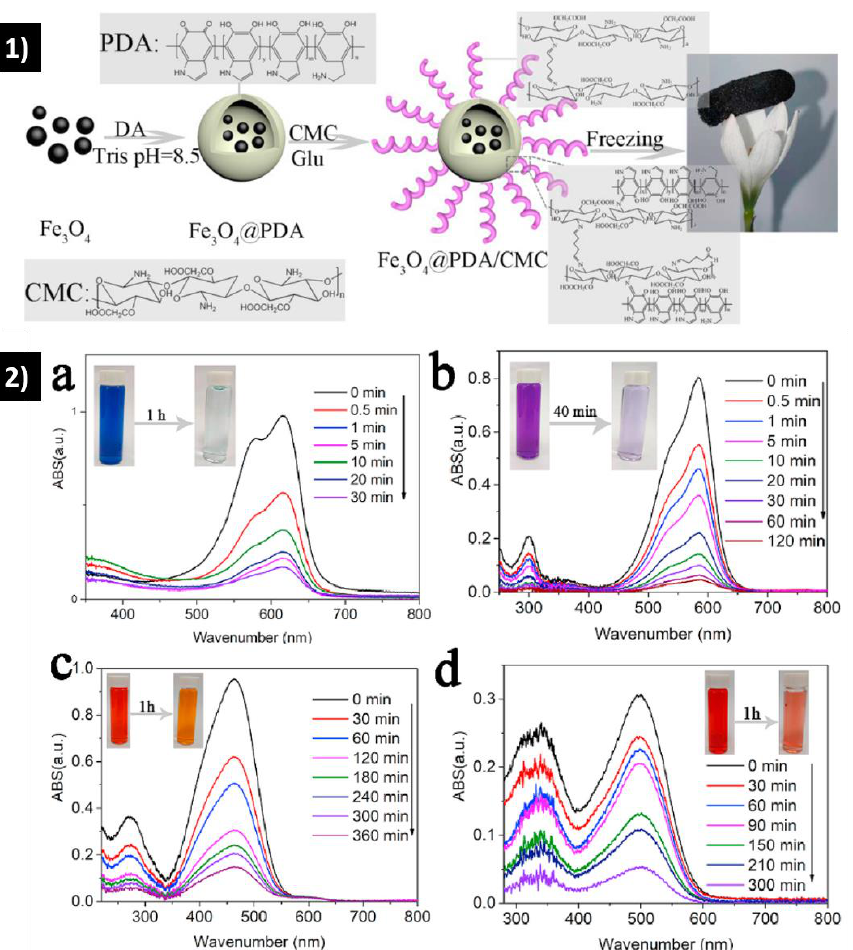
Figure 6. ( 1 ) Schematic illustration of the preparation of Fe3O4@PDA/CMC aerogel. ( 2 ) UV spectrum of adsorption times of MB ( a ), CV ( b ), MO ( c ), and CR ( d ) onto Fe3O4@PDA/CMC aerogel [99]. Compressibility is a desired property when an aerogel is developed [101]. In 2022, Grishkewich et al. reported elaborating compressible cellulose/(3-mercaptopropyl) tri- methoxysilane aerogels by freeze-drying [102]. A sophisticated chemical process was em- ployed to modify the aerogels. The process had an adsorption capacity of 186.7 mg/g and showed a high affinity for methyl orange dye through interactions at the adsorbent sur- face and physisorption. Other cellulose-based aerogels modified with polydopamine have been particularly interesting because of the multifunctional structure of polydopamine, which increases their hydrophilicity and make them very sensitive to organic dyes. At the same time, they are able to store and convert solar energy even in water that is under an oil layer [103,104].